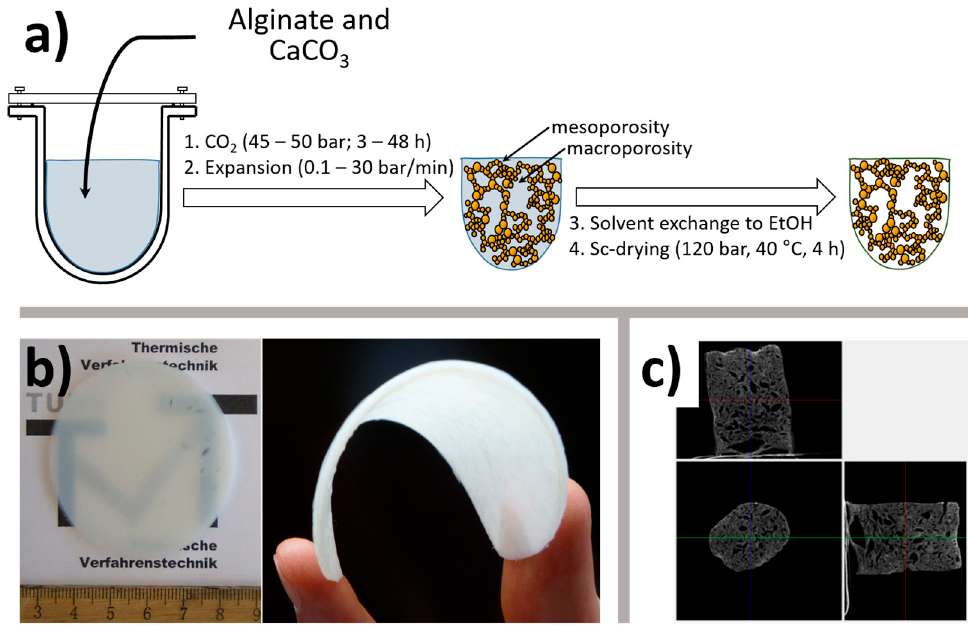
Figure 4. ( a ) general scheme of the carbon dioxide induced gelation; ( b ) as synthesized translucent monolithic alginate aerogel from 0.5 wt % sodium alginate solution (left panel), alginate aerogel after compression under a pressure of 10 kN/m 2 becomes flexible; ( c ) microtomography image of alginate–lignin aerogels produced by CO 2 induced gelation depressurized at 30 bar/min to introduce macropores. Part ( a ) is reprinted from Martins et al. [42], Copyright (2015), with permission from Elsevier; part ( b ) is reproduced from Gurikov et al. [39] with permission from the Royal Society of Chemistry; part ( c ) is reprinted from Quraishi et al. [43], Copyright (2015), with permission from Elsevier.